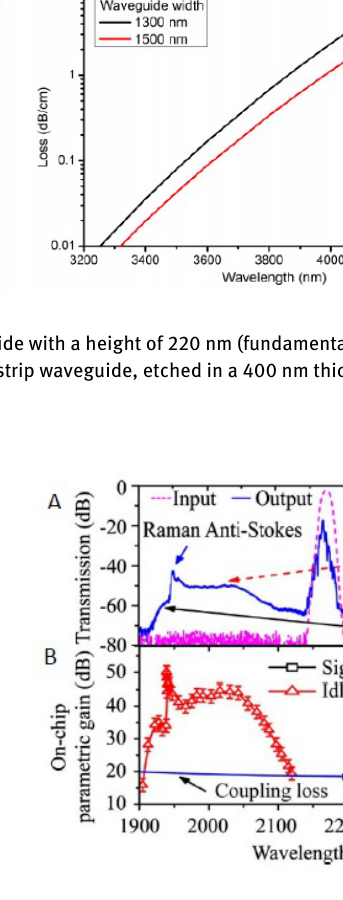
Fig. 13. Parametric ampification in the mid-infrared using the waveguide described in Fig. 12, pumped using ps pulses centered around 2120 nm. (a) The spectrum of the pump pulses before and after passing through a 2 cm long waveguide; (b) amplification and conversion eflciency as a function of seed wavelength. The total insertion loss of the chip is shown in blue. Adapted from refer- ence